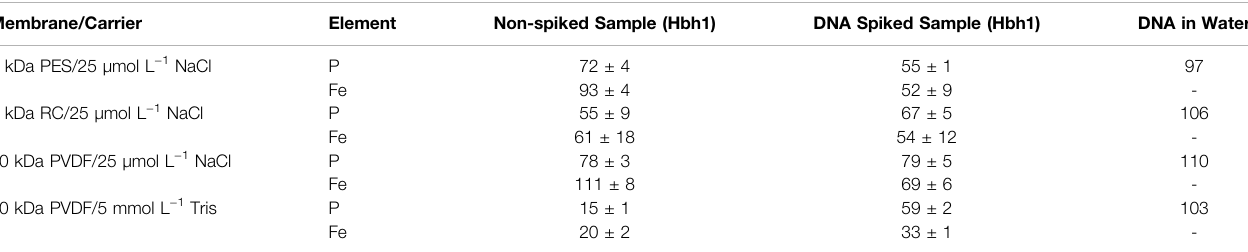
TABLE 2 | Recoveries [%] for AF4 separation of non-spiked and spiked water samples ( n = 2; DNA in water n = 1).